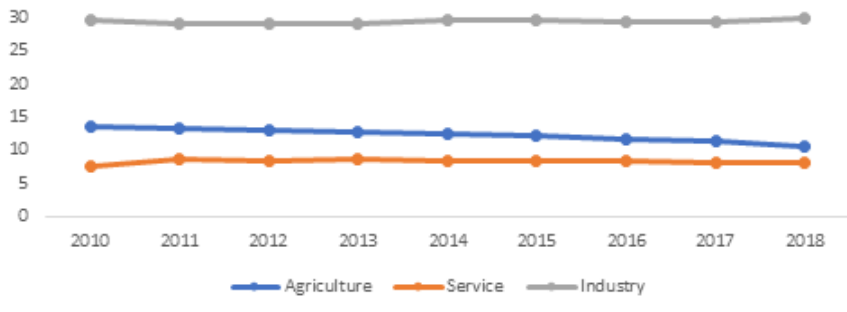
Figure 3: Share of Agriculture, Service, and Industry on East Java GRDP Source: Statistics Indonesia